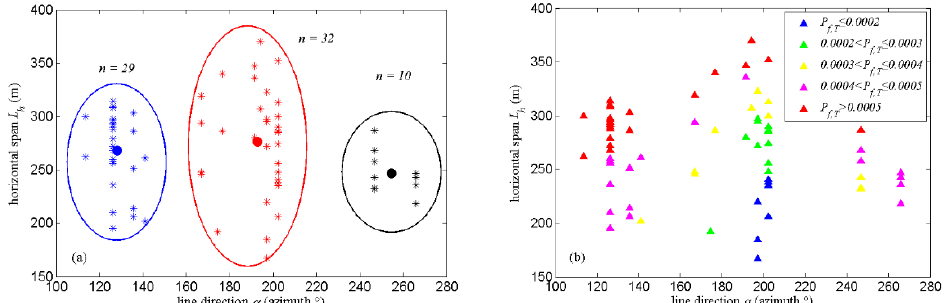
Figure 14. Clusters of suspension towers and their failure classes. ( a ) clusters of suspension towers; ( b ) failure classes of suspension towers.